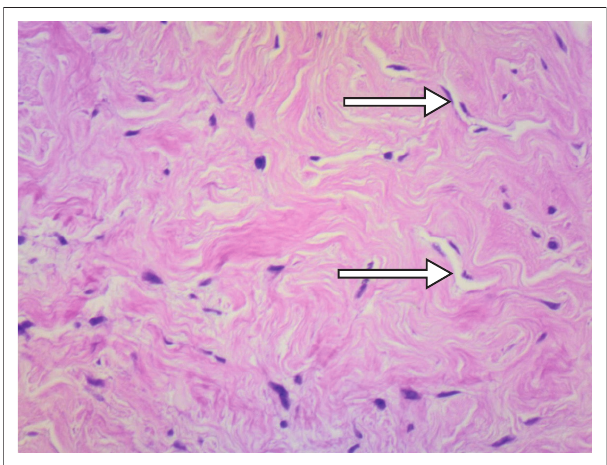
FIGURE 4: Arrows indicate the pseudovascular spaces.